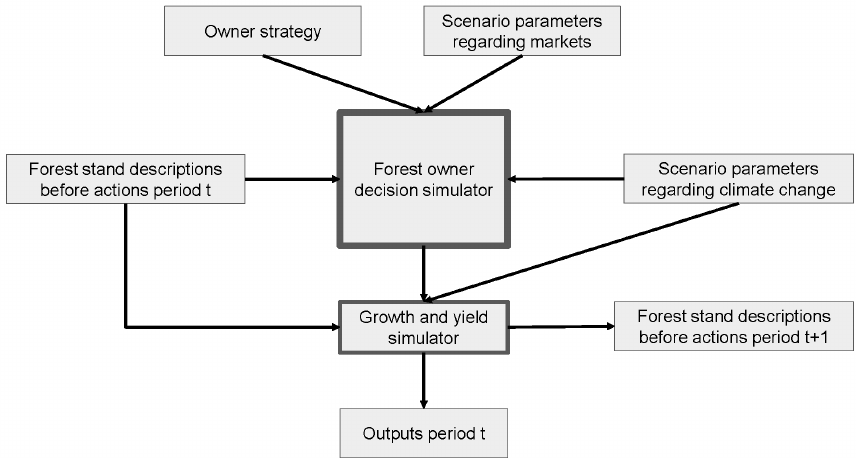
Figure 1. Overview of the forest simulator with data and models that were interconnected to project the development of the forest of one forest holding from period t to period t+1.